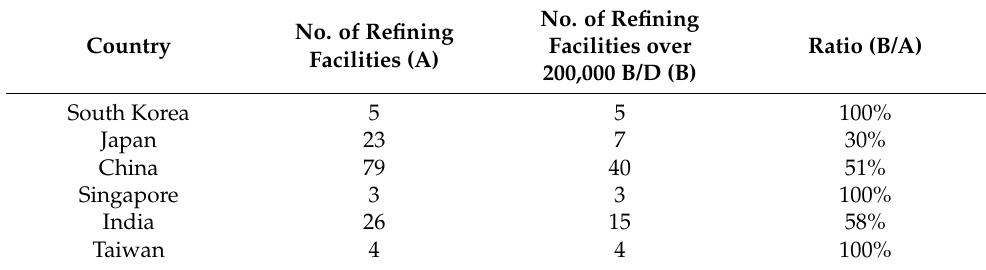
Table 3. The ratio of refining facilities over 200,000 B/D (Barrels per